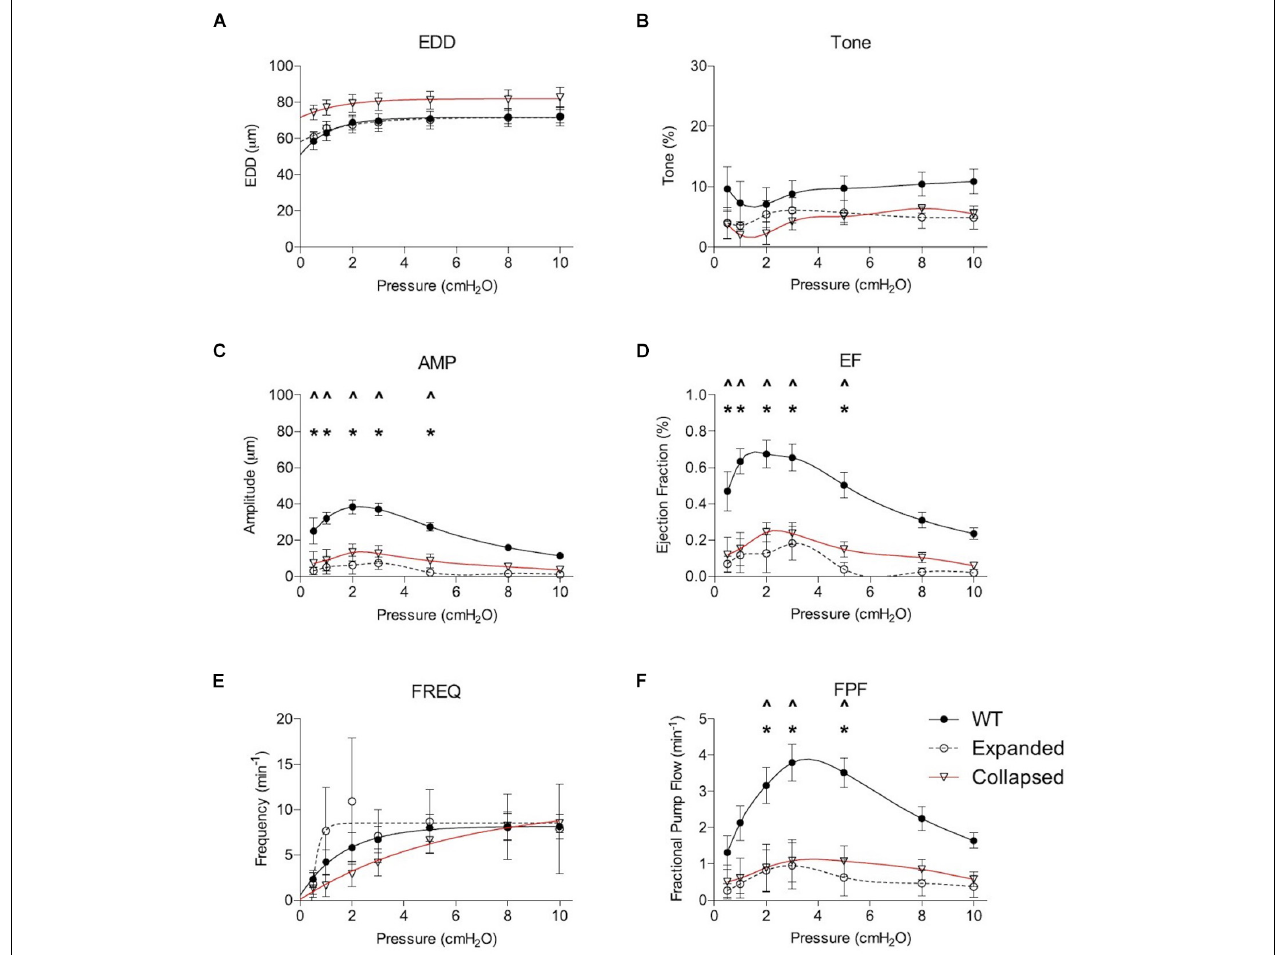
FIGURE 2 | Expanding and Collapsed TNF-Tg mice show reduced amplitude (AMP), ejection fraction (EF), and fractional pump flow (FPF) compared to WT. Lymphatic contractile parameters are plotted against pressure on the x -axis, and include end diastolic diameter (EDD; A ), tone (B) , contraction amplitude (AMP; C ), ejection fraction (EF; D ), contraction frequency (FREQ; E ) and FPF (F) . All data are means ( ± SEM). When error bars appear missing, they are actually contained within the data points. * P < 0.05 Expanded vs. WT, ∧ P < 0.05 Collapsed vs.